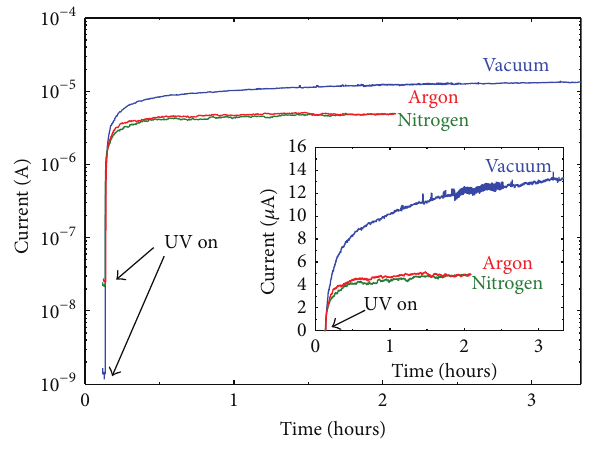
Figure 3: Photo-current increase under UV excitation of a single ZnO nanowire device in vacuum and two different inert gas atmospheres plotted in a logarithmic scale. The linear scaled inset clearly shows that for nitrogen and argon the current saturates after 2 hours, but not in vacuum. All measurements were performed at = 5 𝑉 ds